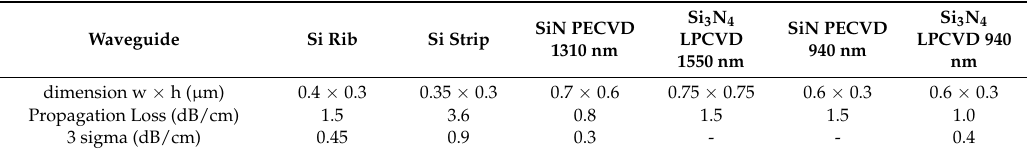
Table 1. Si and SiN waveguide properties and propagation losses.